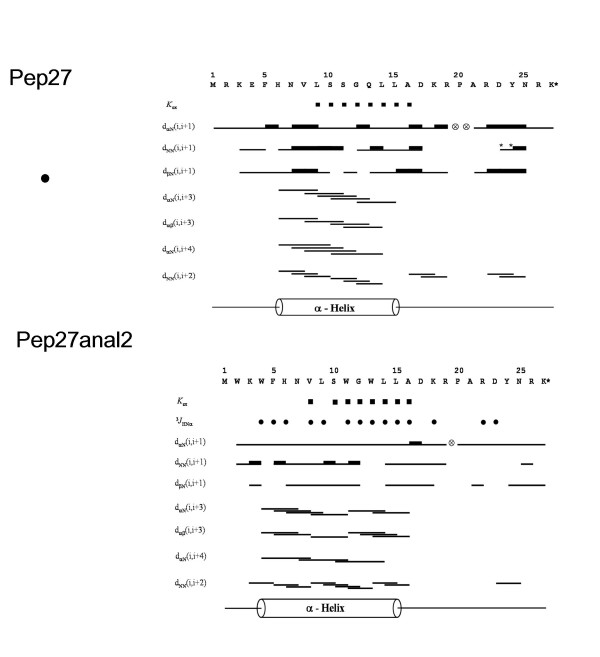
Summary of the sequential and short-range NOEs for Pep27 and for Pep27anal 2 in TFE/water (1:1 v/v) at pH 7.2 and 15°C, showing sequential and short-range NOE contacts. Amide proton exchange rates (■), backbone vicinal coupling constants (●; 3JHNα < 6 Hz) are also indicated. represents a proline residue The helical region is represented as a long cylinder.